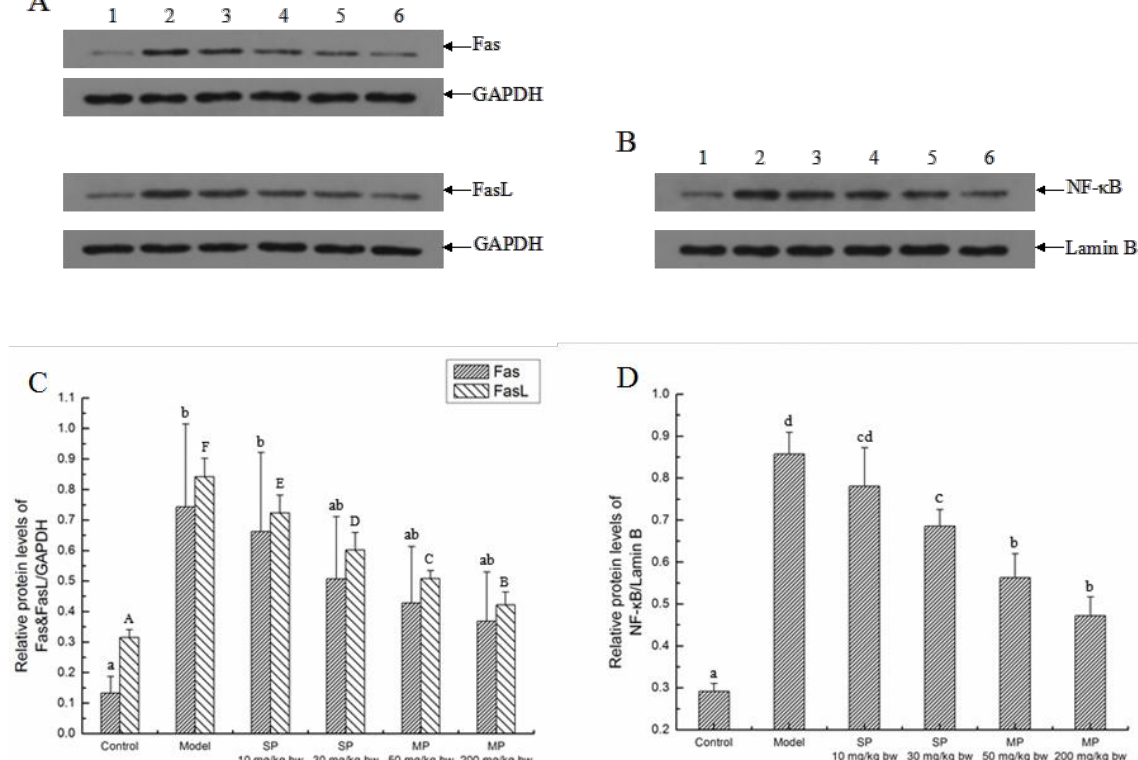
Figure 6. The relative protein expressions of Fas, FasL and NF-κB in each group. Representative western blots for ( A ) Fas and FasL; ( B ) NF-κB. GAPDH and LaminB were used as internal controls for liver tissue and nucleus, respectively; ( C ) Relative protein levels of Fas & FasL/GAPDH; ( D ) Relative protein level of NF-κB/LaminB. Values not sharing a common letter (a, b, c, d) in ( C , D ) differ significantly of Fas/GAPDH and NF-κB/LaminB at p < 0.05, separately. Values not sharing a common letter (A, B, C, D, E, F) in ( C ) differ significantly of FasL/GAPDH at p < 0.05. SP, synthetic pentapeptide; MP, mixed corn peptides. Numbers 1–6 indicate groups of Control, Model, SP-10 mg/kg bw, SP-30 mg/kg bw, MP-50 mg/kg bw and MP-200 mg/kg bw